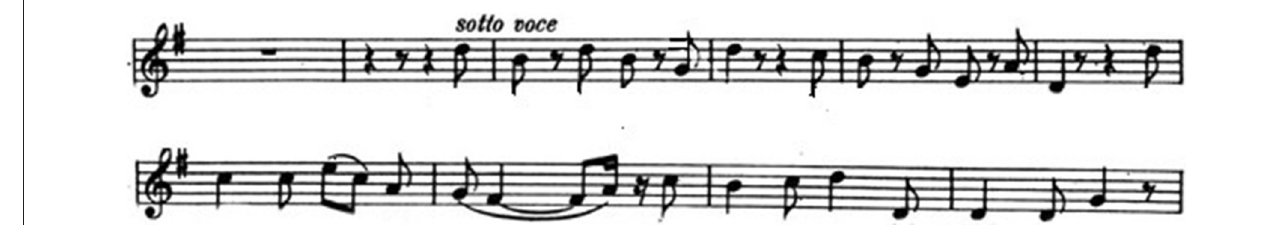
FIGURE 5 | The quartet-theme.